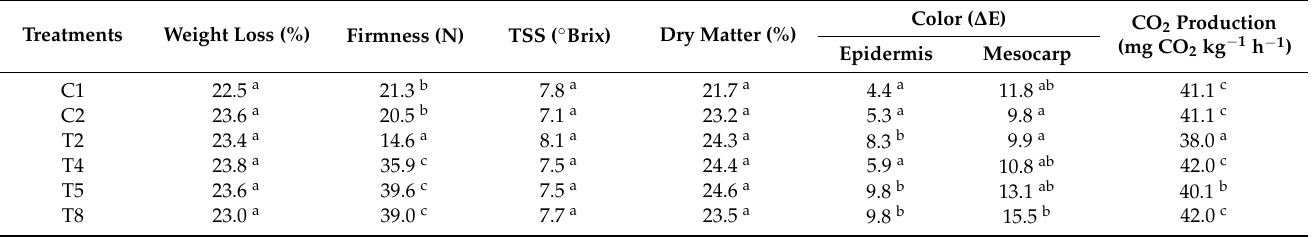
Table 3. The effect of polymeric nets manufactured with 60/40 PLA/PPBAT + PEO at different concentrations + 1% chitosan on the final maturity of Hass avocado fruit after nine days of storage at ambient